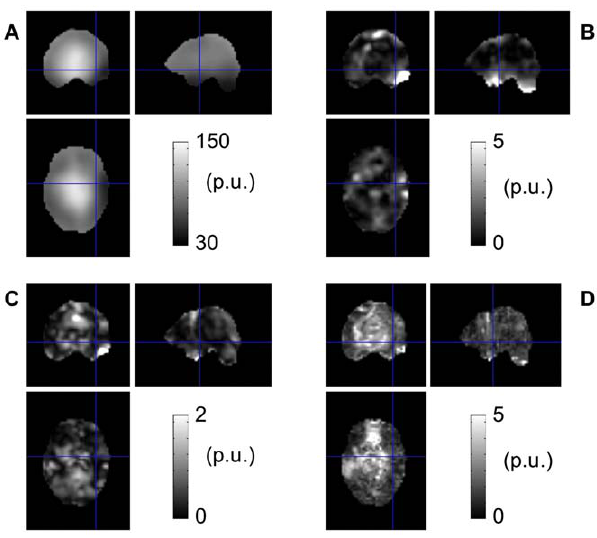
Figure 2. Precision and linearity of the 3D EPI method. Typical B 1 + (a), non-linearity (b) instability (c) and SD B1 + (d) maps obtained with the optimal configuration using a maximum RF nominal value of 310 u and off-resonance minimization.